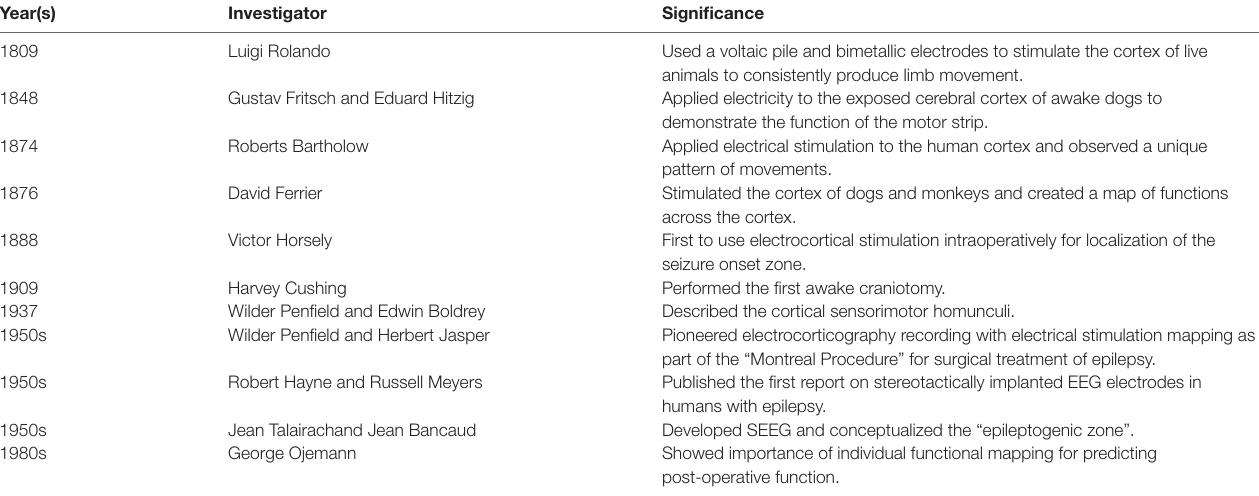
TABLE 1 | Selected landmarks in the history of electrical stimulation mapping of brain function with intracranial electroencephalography